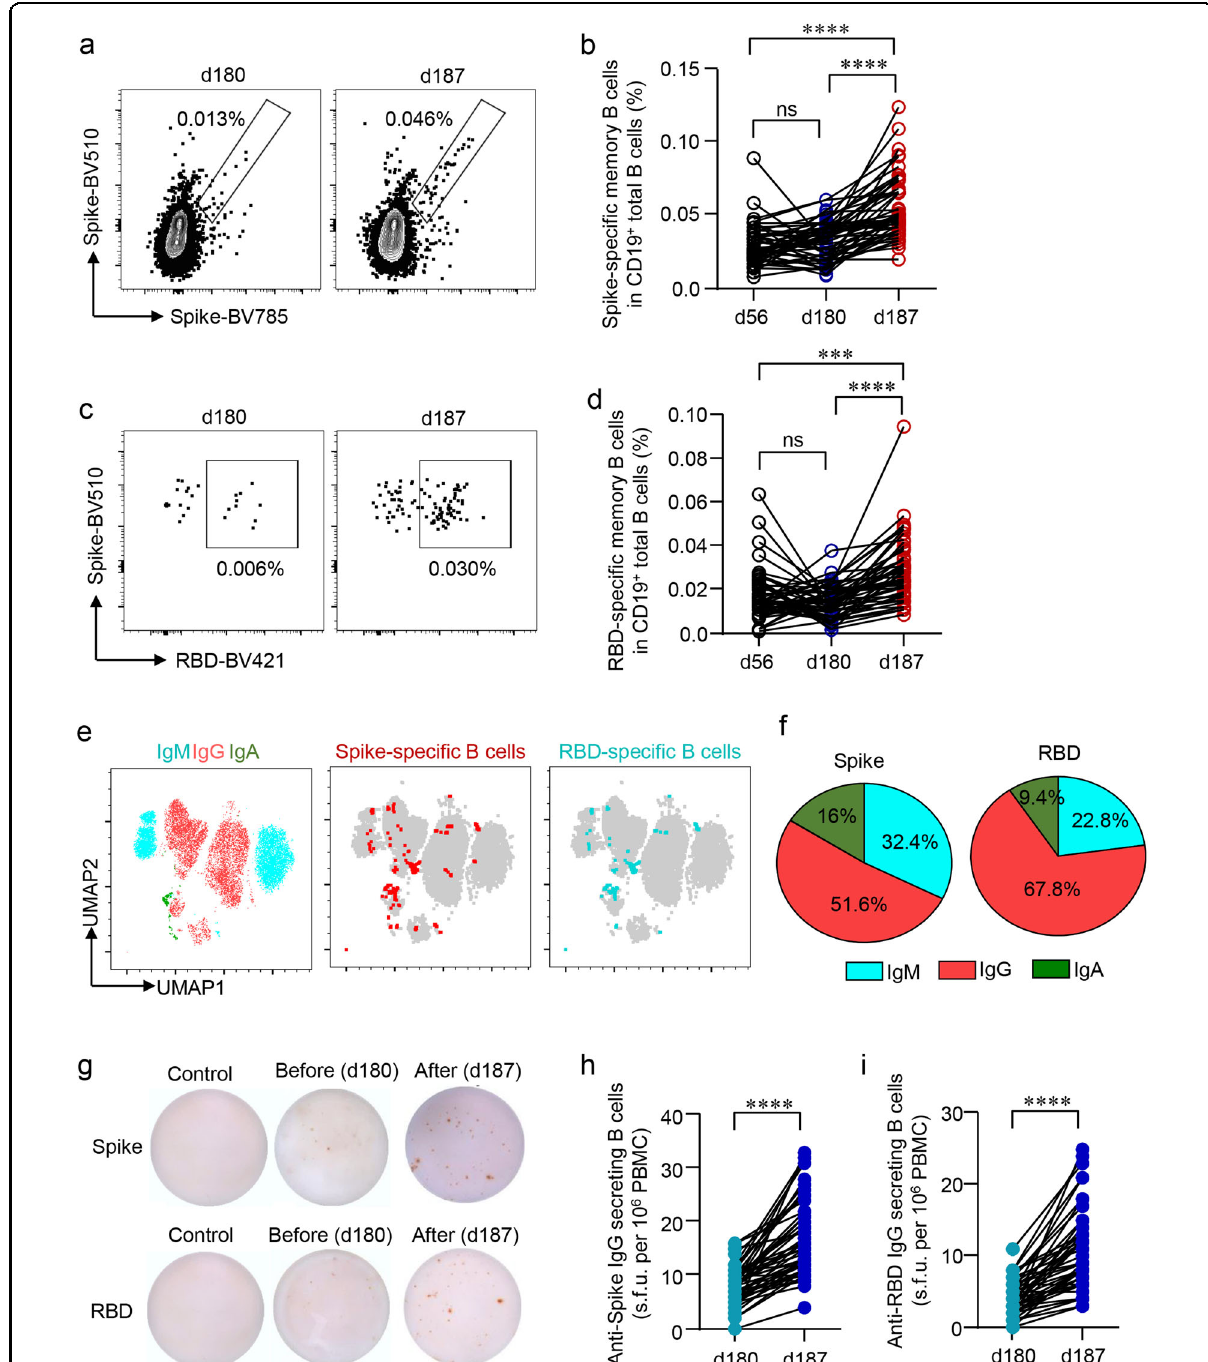
Fig. 2 SARS-CoV-2-speci fi c memory B cell after a third dose of inactivated vaccine. Recombinant spike or receptor-binding domain (RBD) proteins were used to label SARS-CoV-2-speci fi c BCR. Data were acquired by fl ow cytometry. a , c Representative FACS plots for the spike- or RBD- speci fi c BCR were shown. b , d Longitudinal changes of spike- or RBD-speci fi c memory B cells were summarized. e IgG + , IgA + , and IgM + B cells were measured by fl ow cytometry. The UMAP plot demonstrated the distribution of spike- and RBD-speci fi c memory B cells in IgG + , IgA + , and IgM + B cells. f Mean percentages of each BCR subtype in spike- and RBD-speci fi c B cells were summarized. g Spike- or RBD-speci fi c IgG-secreting B cells were measured by ELISpot after incubating PBMCs in spike- or RBD-coated plates for 18 h. Representative ELISpot images were shown. h , i Numbers of Spike- or RBD-speci fi c IgG-secreting B cells per 10 6 PBMCs were expressed as spot-forming units (s.f.u.) and summarized. Comparisons were done by one-way ANOVA corrected for multiple comparisons in b , d and Student ’ s paired t -test in h , i . *** P < 0.001, **** P < 0.0001; ns, not signi fi